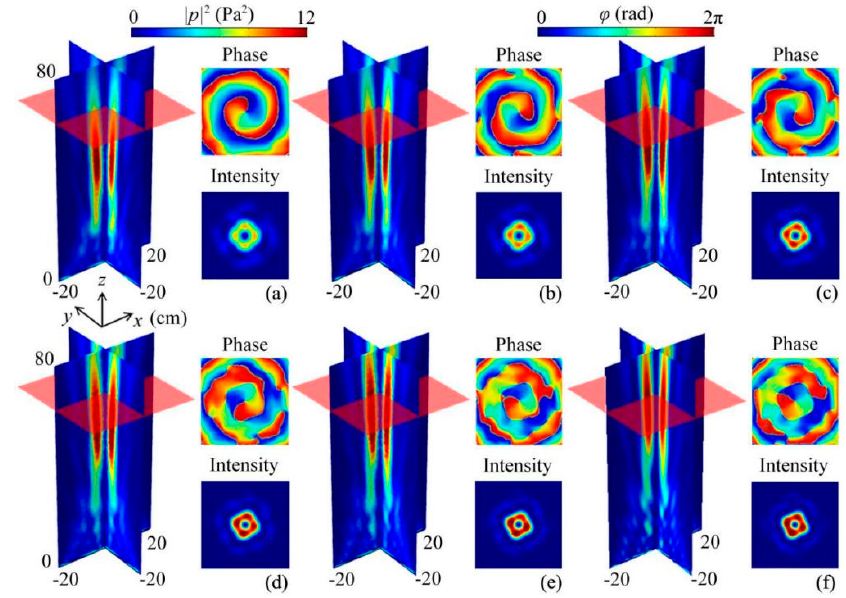
Figure 5. Simulated 3D reflected intensity distributions of the ABV beam created by the quasi-3D metasurface at ( a ) 8.2, ( b ) 8.7, ( c ) 9.2, ( d ) 9.7, ( e ) 10.2, and ( f ) 10.7 kHz. Insets on the right side represent the phase and intensity distributions at a cross section z = 60 cm (red translucent